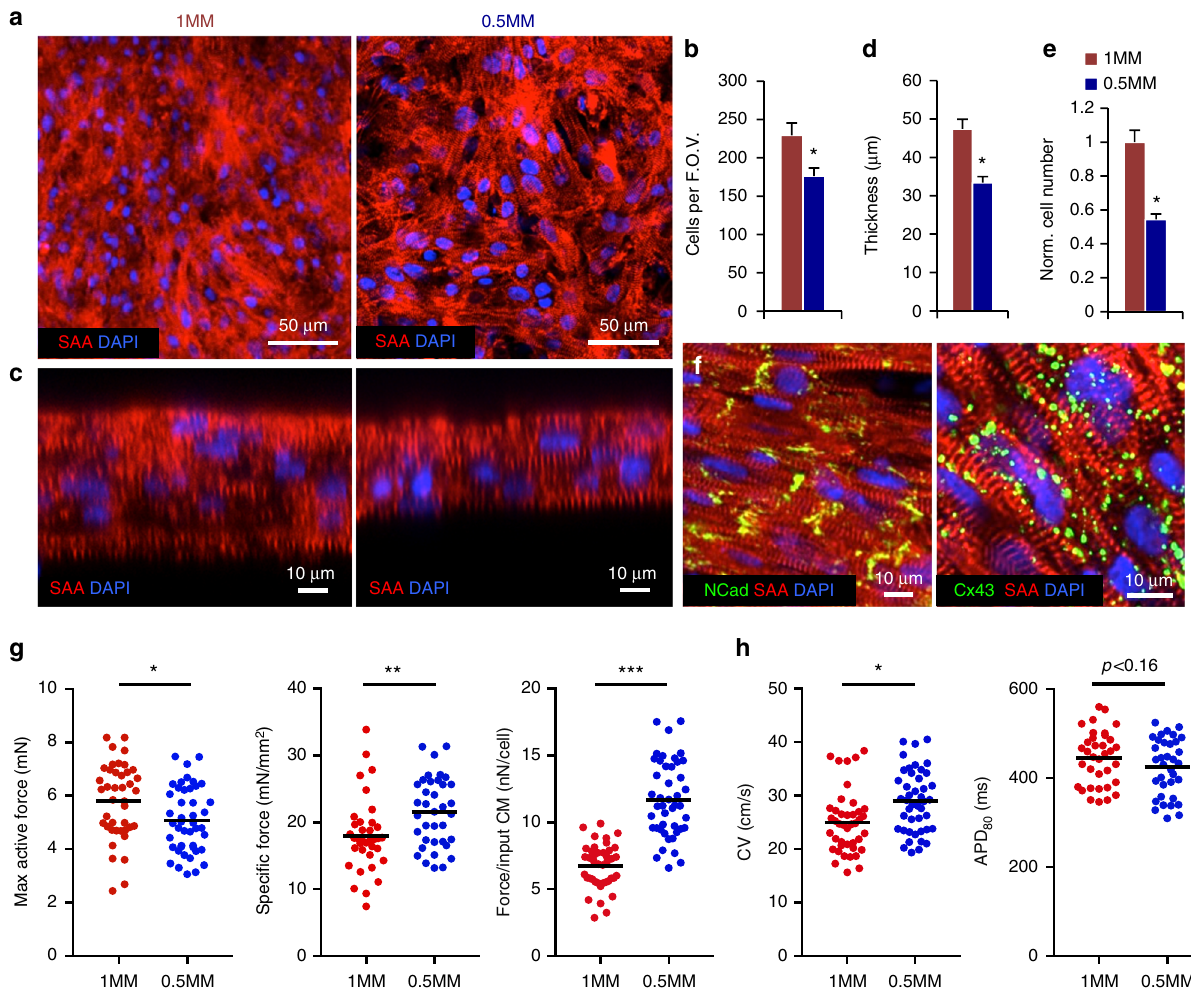
Fig. 3 Lowering density of hiPSC-CMs improves cardiopatch function. a Representative confocal images of 3-week-old cardiopatches generated from 1 million (1MM) and 0.5 million (0.5MM) hiPSC-CMs stained for SAA. Scale bar 50 µ m. b Quanti fi cation of average number of cells per fi eld of view in 0.5 and 1MM cardiopatches using a ×63 objective (2 µ m slice); n = 13/16 patches (1/0.5MM) from seven differentiations, three to four random fi elds of view per patch; * p = 0.0083, unpaired t -test. c Representative optical cross-sections of 1MM and 0.5MM cardiopatches. Scale bar 10 µ m. d Quanti fi cation of cardiopatch thickness made from 0.5 and 1MM cells; n = 22/25 patches (1/0.5MM) from 7/11 differentiations, average 2 thickness measurements per patch; * p < 0.0001, unpaired t -test. e Calculated cell numbers in cardiopatches (normalized to 1MM patch) based on average patch thickness and cells per fi eld of view; n = 13/16 patches (1/0.5MM) from seven differentiations; * p < 0.001, unpaired t -test. f Representative confocal images of 3 week